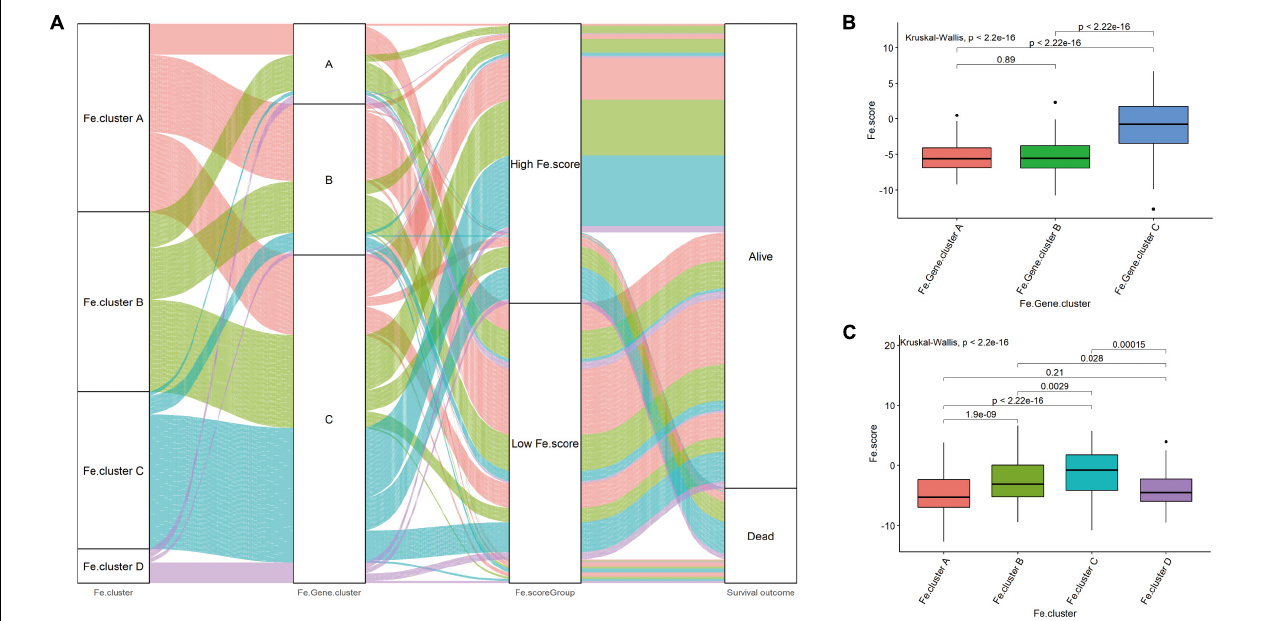
FIGURE 5 | Correlation between Fe.scores, Fe.clusters, and Fe.gene.clusters. (A) The Sankey diagram shows the grouping of 544 EC samples. (B) The difference in Fe.score between Fe.gene.cluster groups. (C) Fe.score difference between Fe.cluster